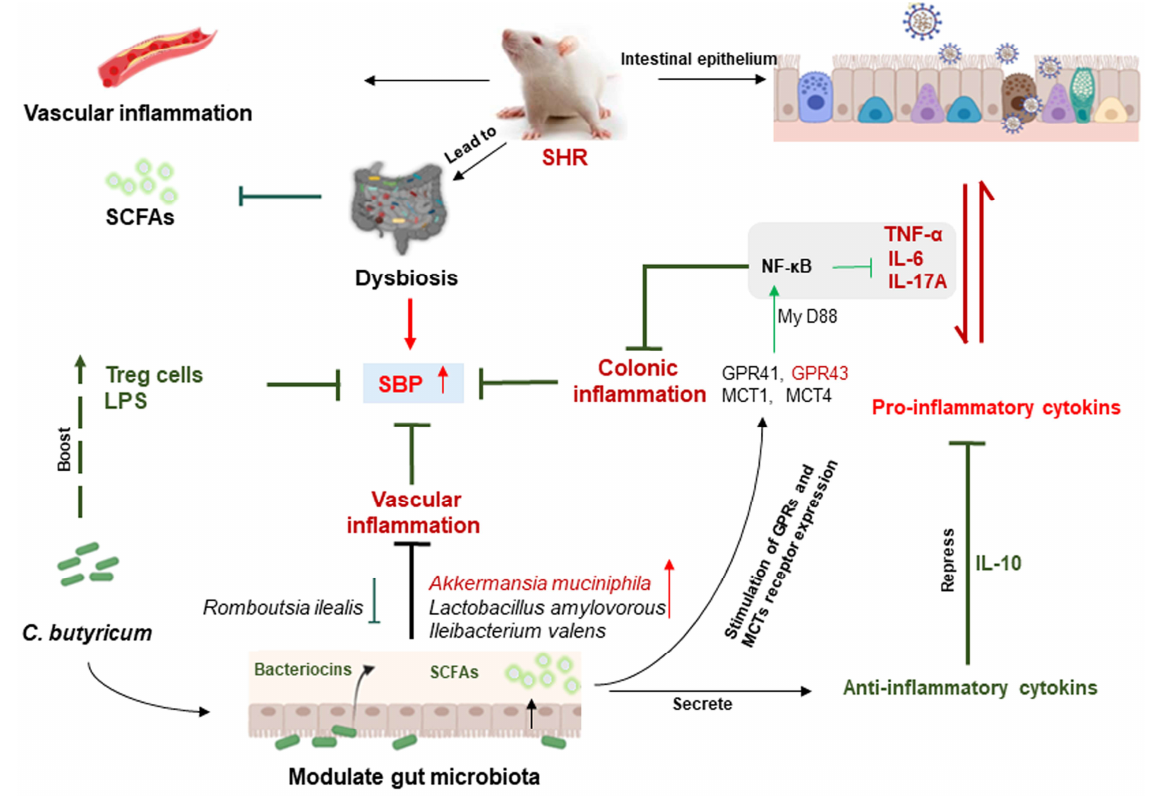
Figure 9. The mechanism by which C. butyricum reduces the SBP of